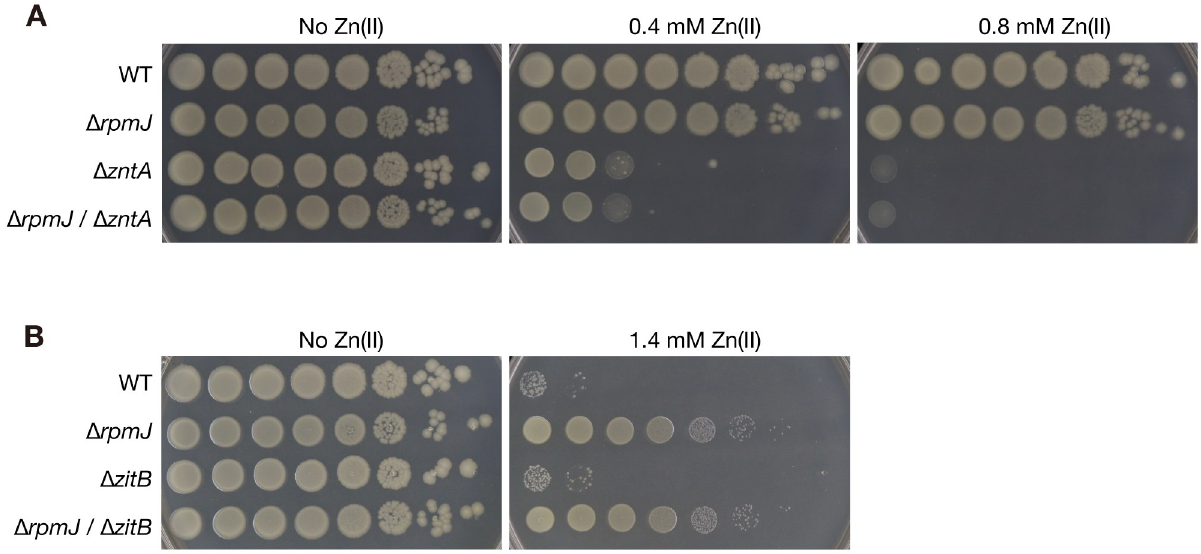
Fig 6. Knockout of zntA abolishes the zinc resistance caused by the rpmJ knockout. A. Overnight cultures of the wild-type strain (WT), the rpmJ mutant ( Δ rpmJ ), the zntA mutant ( Δ zntA ), and the rpmJ and zntA double knockout mutant ( Δ rpmJ / Δ zntA ) were serially diluted 10-fold, spotted onto LB agar plates without zinc or with 0.4 mM Zn(II) or 0.8 mM Zn(II) and incubated overnight at 37˚C. B. Overnight cultures of the wild-type strain (WT), the rpmJ mutant ( Δ rpmJ ), the zitB mutant ( Δ zitB ), and the rpmJ and zitB double knockout mutant ( Δ rpmJ / Δ zitB ) were serially diluted 10-fold, spotted onto LB agar plates without or with 1.4 mM Zn(II), and incubated overnight at 37˚C. These assays utilized the rpmJ knockout strains whose kanamycin resistant marker was